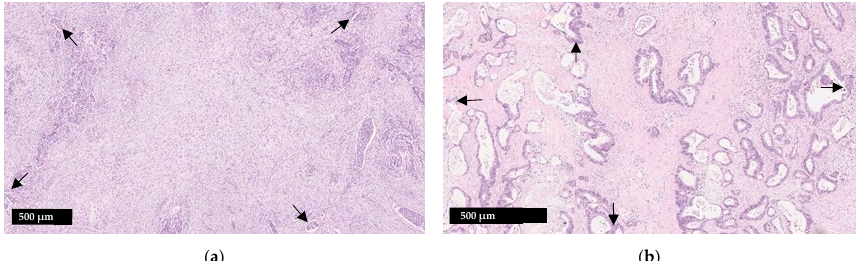
Figure 1. Illustration of the tumor stroma ratio (TSR) ( a ) Stroma-high tumor; ( b ) Stroma-low tumor. When assessing adequacy of a visual field, tumor cells should be present at four sides which are roughly 90 degrees from one another (arrows). Smooth muscle, lymphoid follicles and large vessels with thick muscular walls should be disregarded.